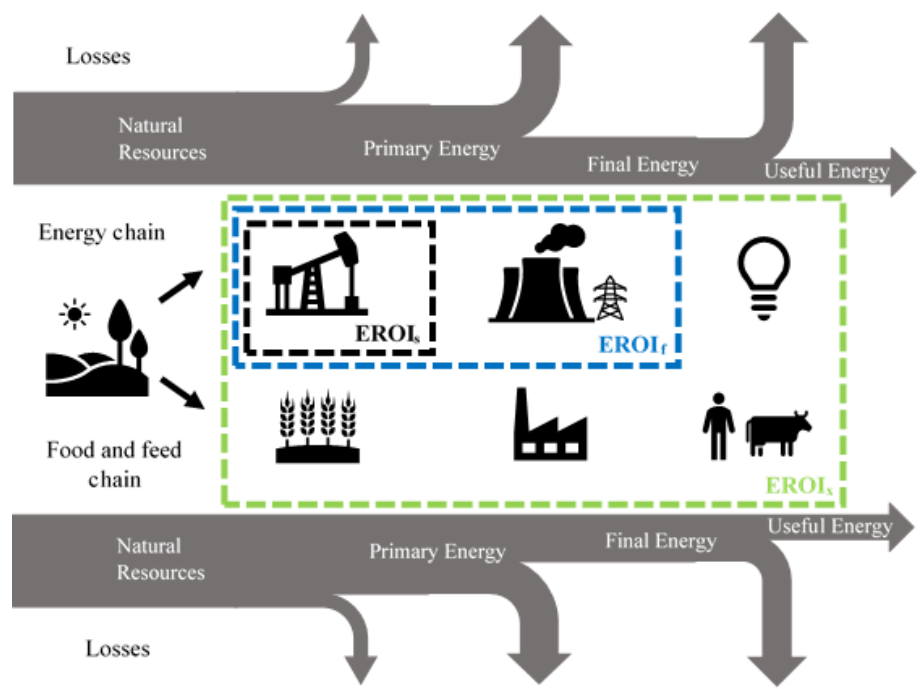
Figure 1. Boundaries of EROI calculations. EROI s : standard, primary stage; EROI f : final stage; EROI x : comprehensive measure introduced by this study, useful stage. Authors’ own scheme.